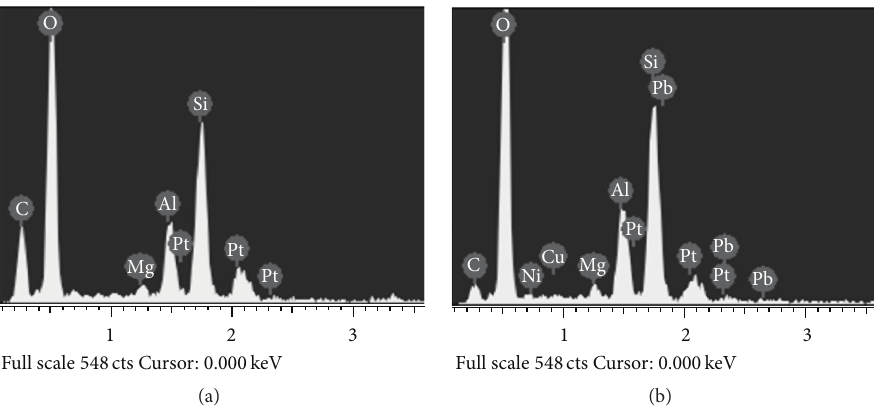
Figure 4: EDX spectra of unused CCB (a) and CCB after adsorption of Pb(II), Cu(II), and Ni(II)